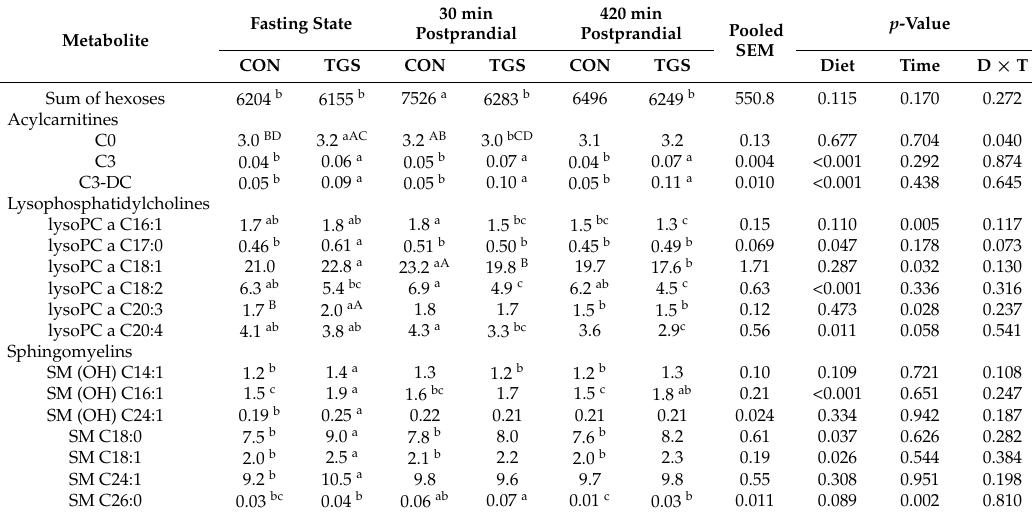
Table 3. Sum of hexoses and selected acylcarnitines, lysophosphatidylcholines and sphingomyelins ( µ mol/L) of pigs fed transglycosylated (TGS) or control (CON) starch diets pre- and postprandially. Fasting State 30 min Postprandial Metabolite Sum of hexoses